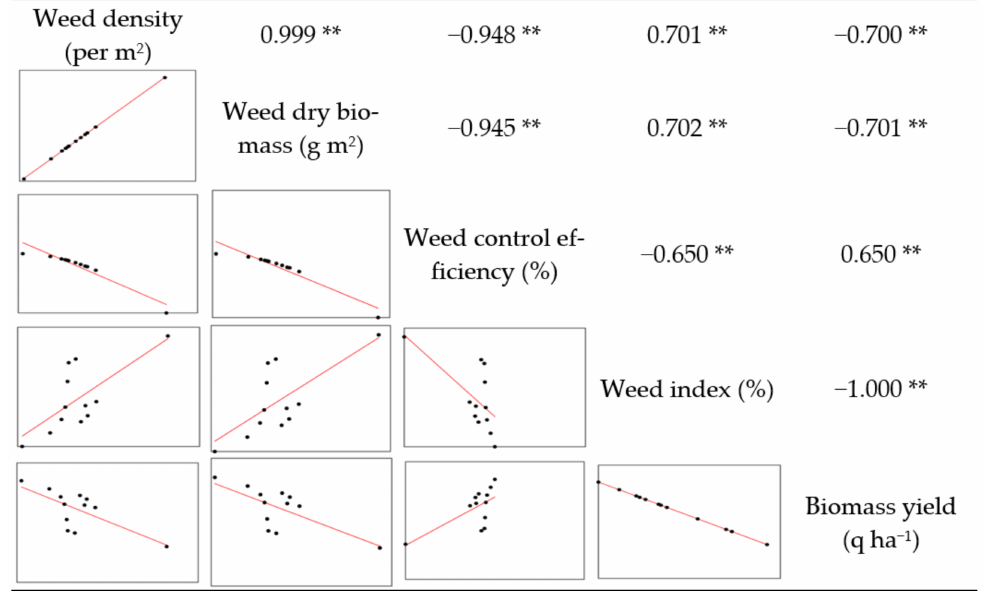
Figure 4. Correlation matrix among weed parameters and yield component. The mean values of the two years’ polled data of the corresponding treatments are used. ** indicate that the corresponding values are significant at p =